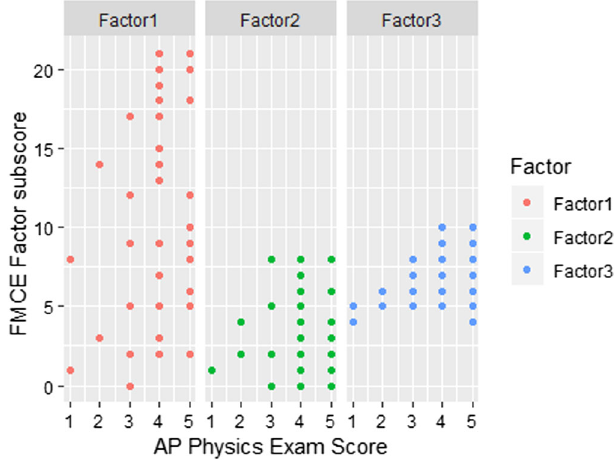
FIG. 4. Subscores on the FMCE factors for students who took the AP